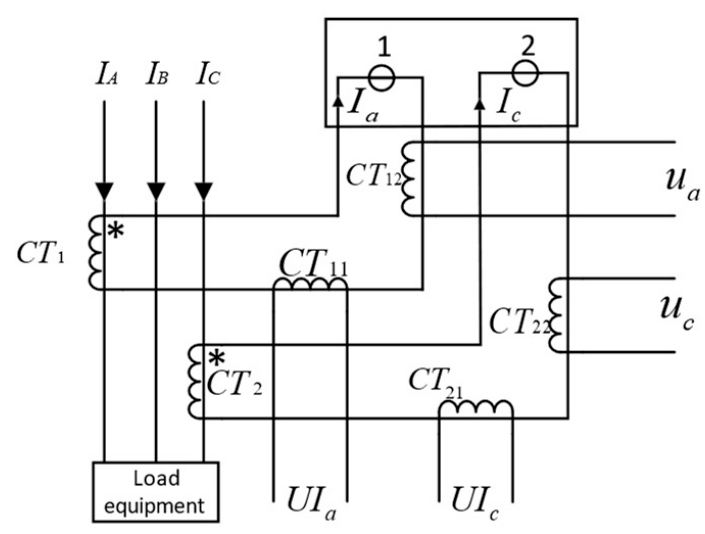
Figure 1. Electronic current transformer fault detection principle diagram.